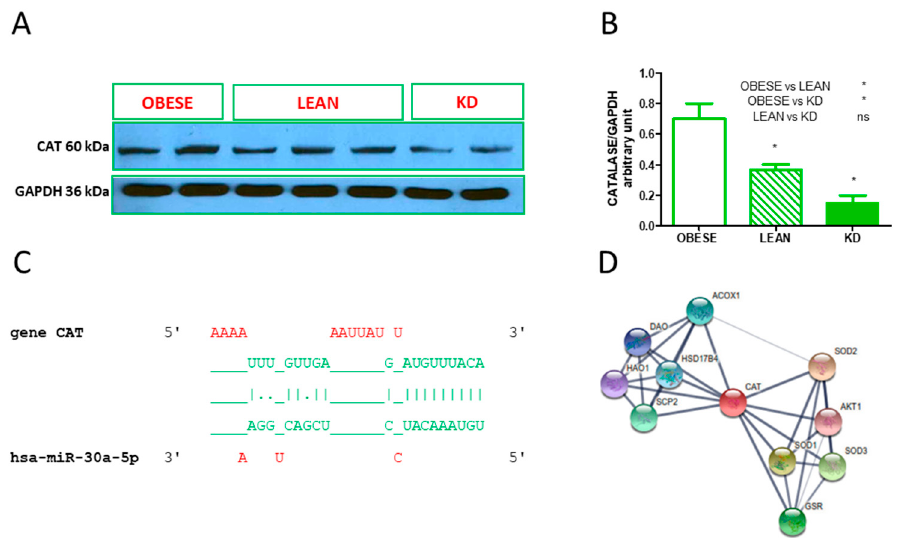
Figure 3. A ketogenic diet (KD) influences catalase gene expression. ( A ) Western blot analysis of catalase (CAT) protein levels in red blood cells from obese, lean and subject in KD. ( B ) Graphical representation of Western blot band intensity, normalized with the loading control GAPDH. ( C ) The CAT gene 3 ′ UTR region interacts with hsa-miR-30a-5p. ( D ) The protein network of CAT enzymes determined by string analysis. Data in panel B represent means ± SD of n = 2 for obese, n = 3 for lean and n = 2 for KD independent tests (* p < 0.05).